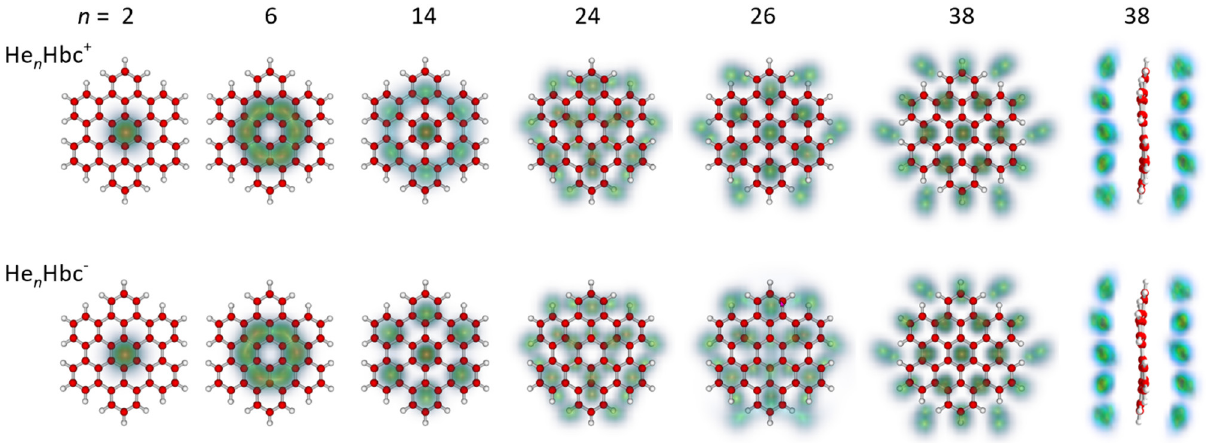
Figure 4. Selected structures of the He n Hbc + and He n Hbc – cluster ions (top and bottom row, respectively); the size n is indicated on top. For each size, the helium densities obtained from the PIMD simulations are superimposed on the structure of Hbc ± . Side views of the 38-mers are shown on the right.